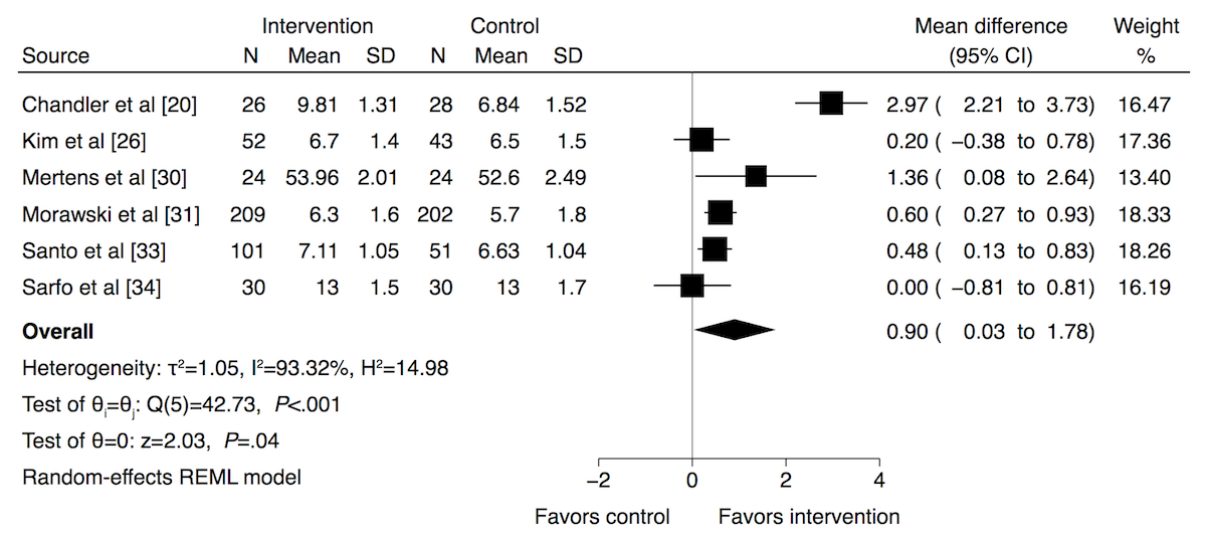
Figure 2. Meta-analysis results and forest plot of the effect of app-based interventions on medication adherence. Mean difference (95% CIs) are denoted by black boxes (black lines). The combined mean difference estimate for all studies is represented by a black diamond, where diamond width corresponds to 95% CI bounds. REML: restricted maximum